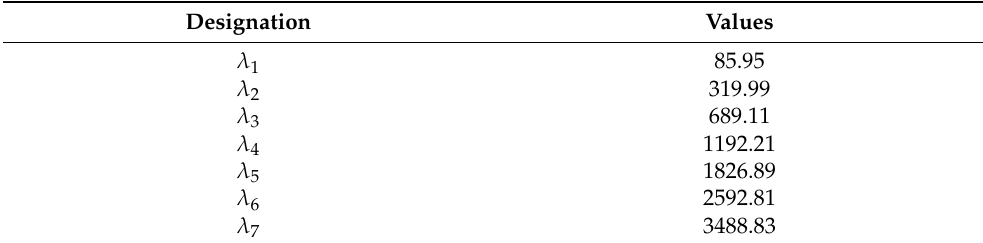
Table 1. The first seven eigenvalues of problem (13) for ℵ = 0.4; γ = 1.472; c = 1.8. Designation Values λ 1